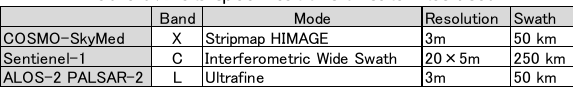
Table 6. Data specifications of satellites used